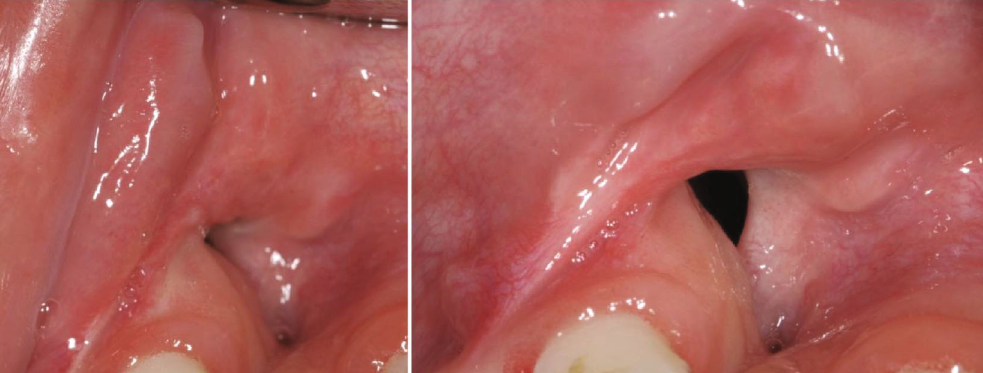
Figure 1: Persistent oronasal communication.